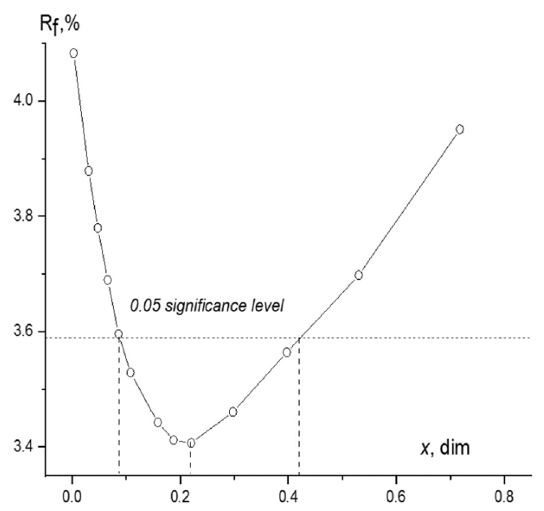
Figure 2. Dependence of the value of R f on the mole fraction of the dimer χ dim in the vapor of POBA The horizontal dashed line corresponds to the Hamilton’s test [21] for uncertainties at significance level 0.05.